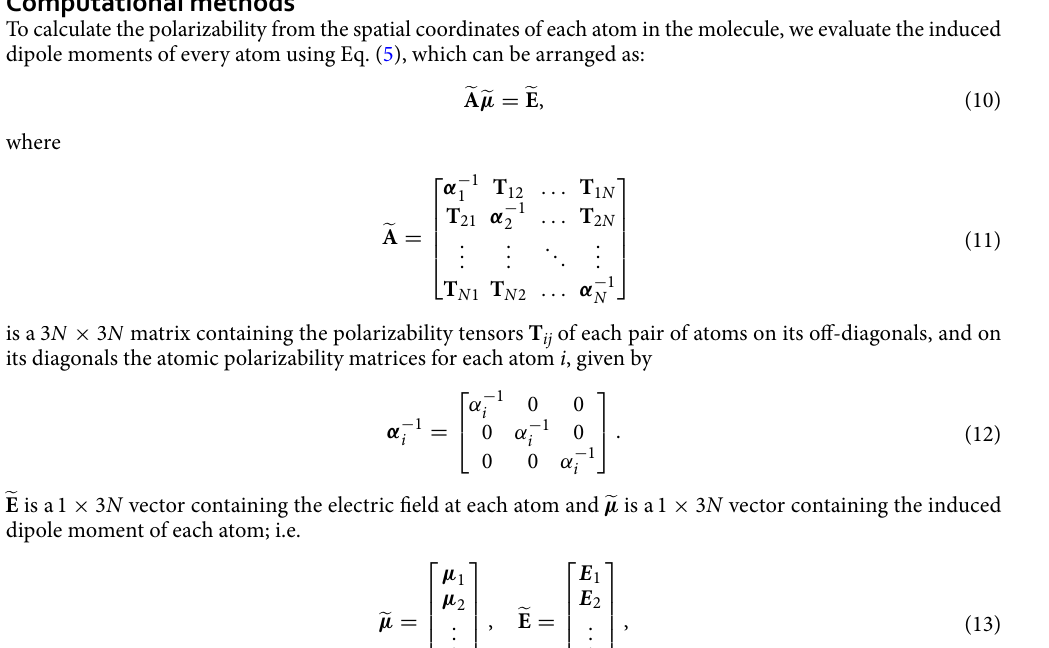
Table 1. Atomic polarizabilities used in calculations.